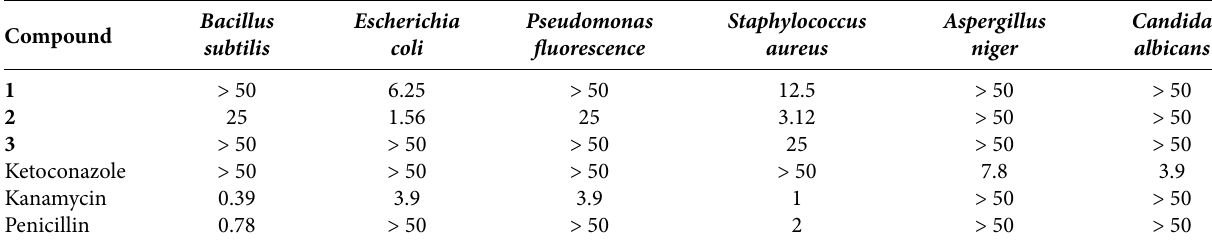
Table 3. MIC values of the compounds (μg/mL) Bacillus Escherichia Pseudomonas Staphylococcus Aspergillus Candida Compound subtilis coli